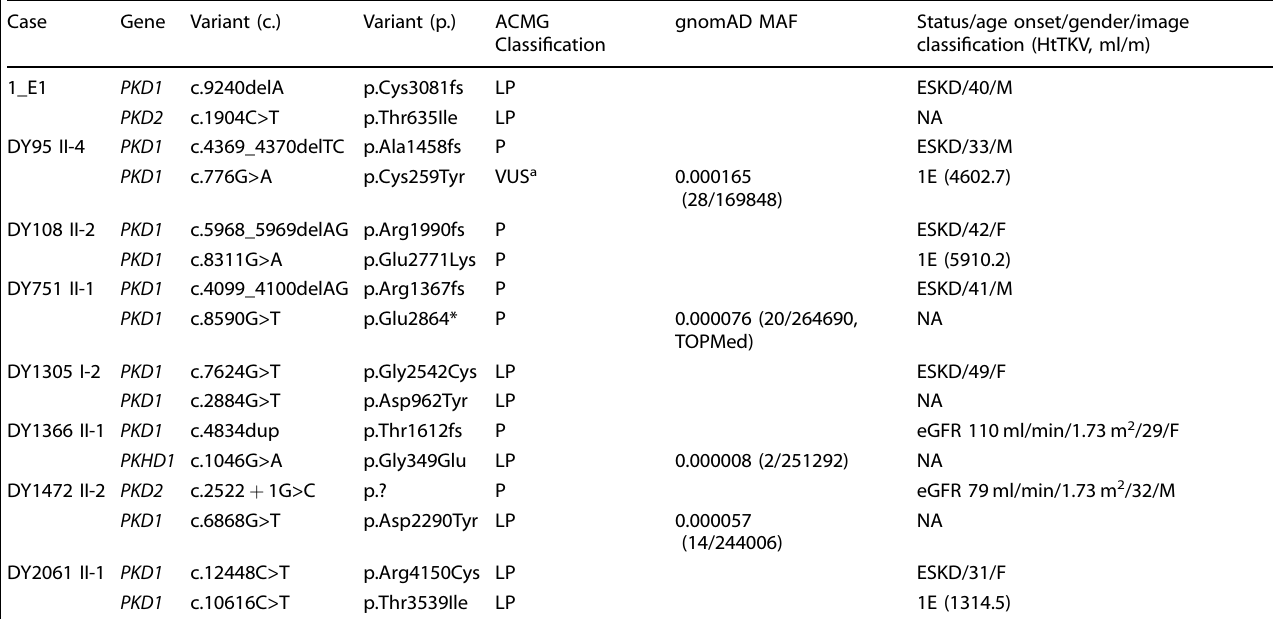
Table 1. Individuals with variants identi fi ed in trans or in different genes. Case Gene Variant (c.) Variant